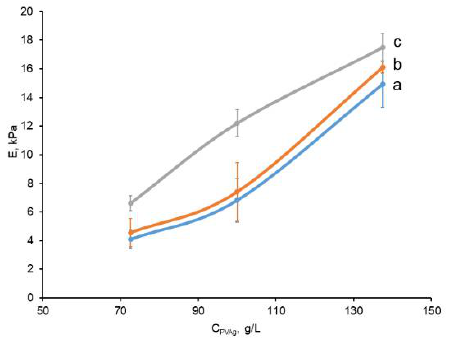
Figure 3. Dependences of the compression Young’s modulus on the feed PVA concentration for the non-filled and composite PVA cryogels prepared from the initial systems listed in Table 1 (blue curve “a”—the filler-free cryogels; red curve “b”—cPVACGs with filler concentration of 11.4 g/L; gray curve “c”—cPVACGs with filler concentration of 22.8 g/L).